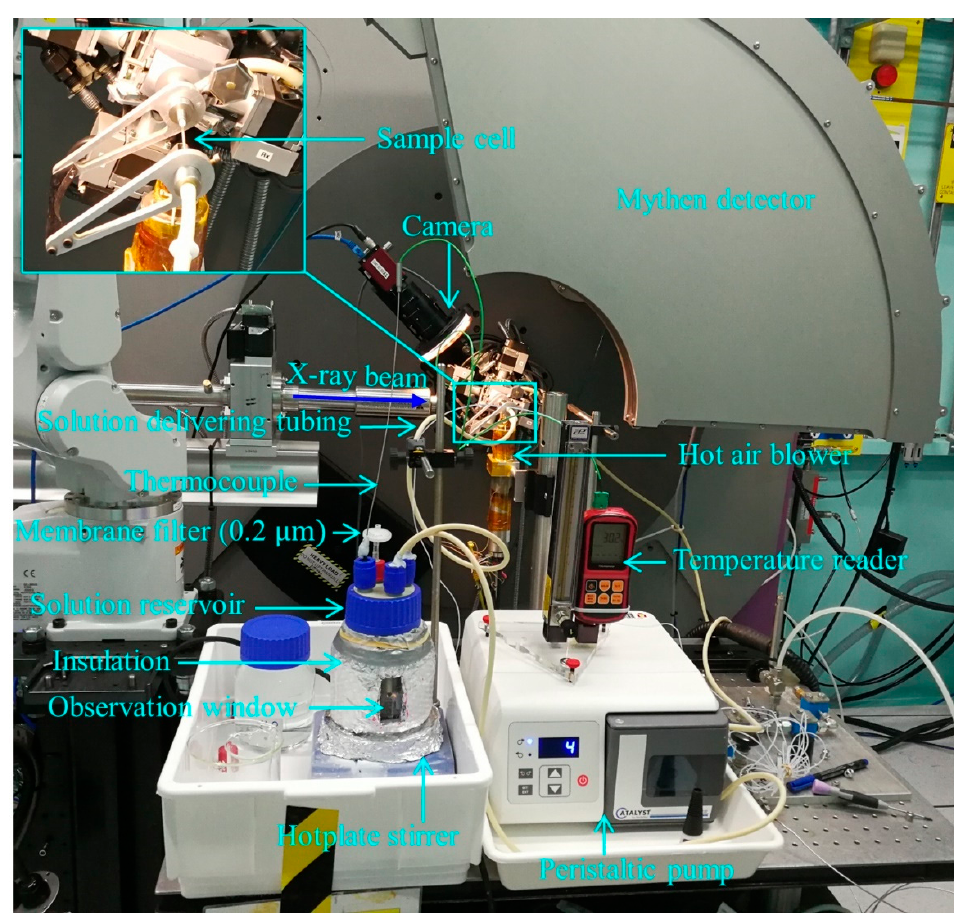
Figure 2. Photo of the flow-through cell setup at the Powder Diffraction beamline at the Australian Synchrotron.